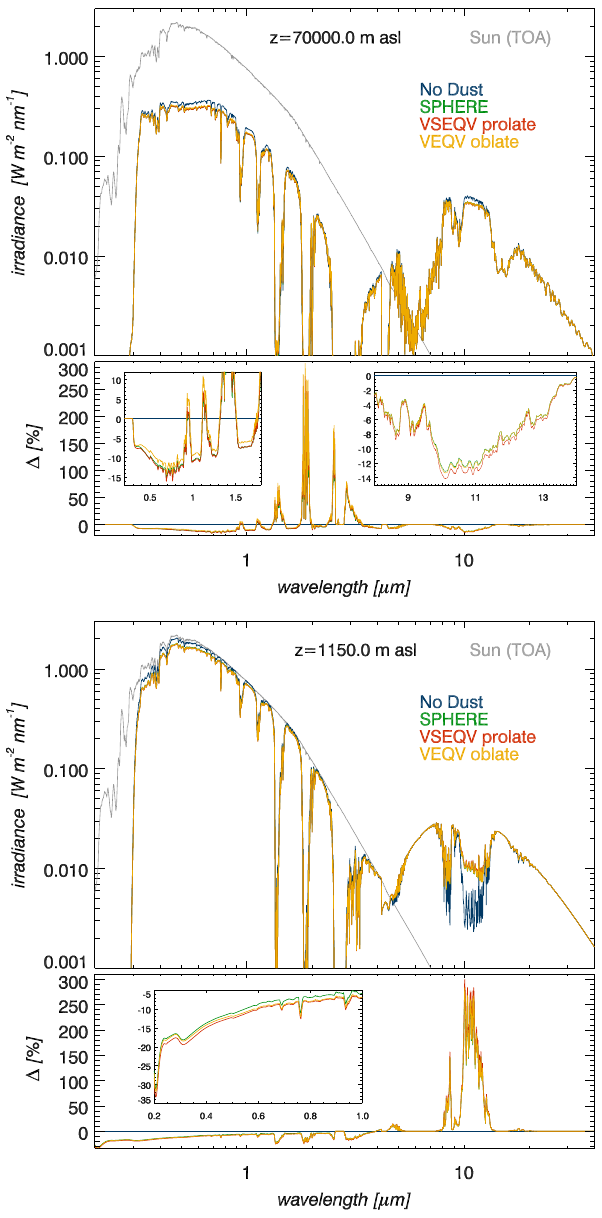
Fig. 12. Simulated solar and thermal irradiances, representative for the mineral dust plume observed on 19 May 2006 over OZT site about noon and considered directly over a mean land surface (Fig. 3, top), for spherical (green), prolate (VSEQV, red) and oblate (VEQV, yellow) spheroidal model particles. 1 represents the deviations to the case of a dust-free atmosphere (blue). (top) Upward part at the TOA ( z = 70kma.s.l.) and (bottom) downward part at the BOA (OZT, z = 1 . 15kma.s.l.). The solar incident irradiance at the TOA is indicated by grey curves. The simulations were performed for a solar zenith angle of 0 ◦